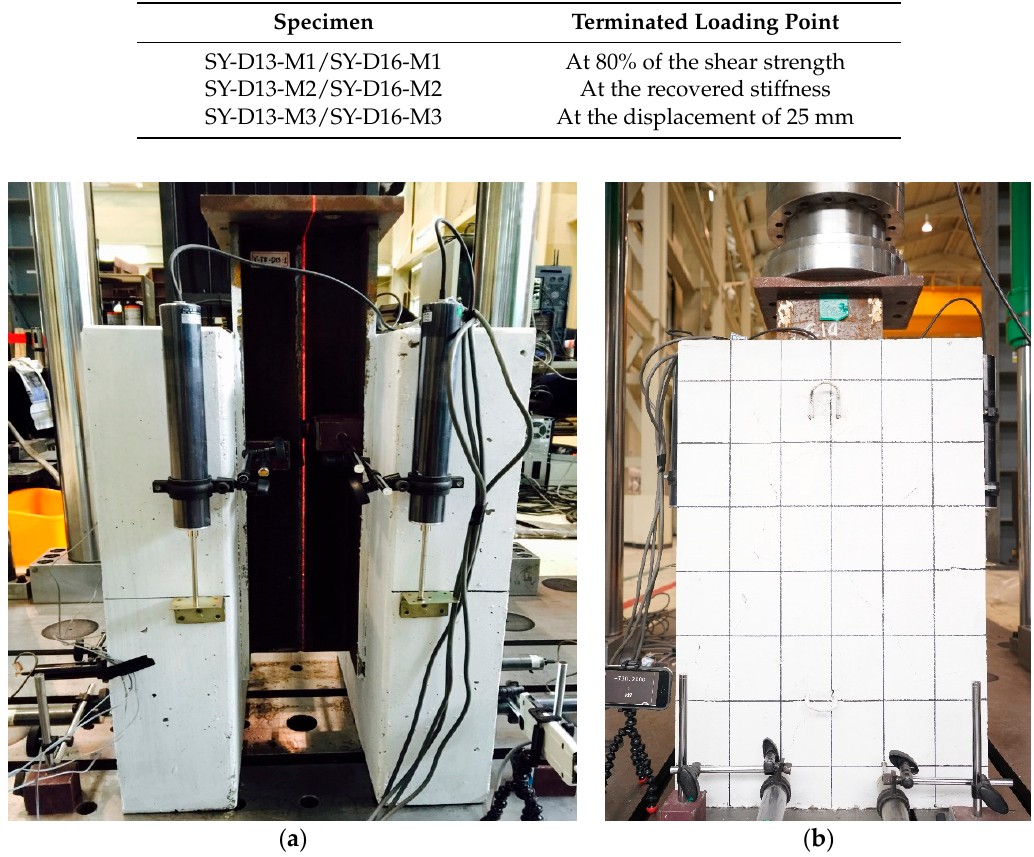
Figure 3. Push-out test setup: ( a ) Front view ; ( b ) Side view.